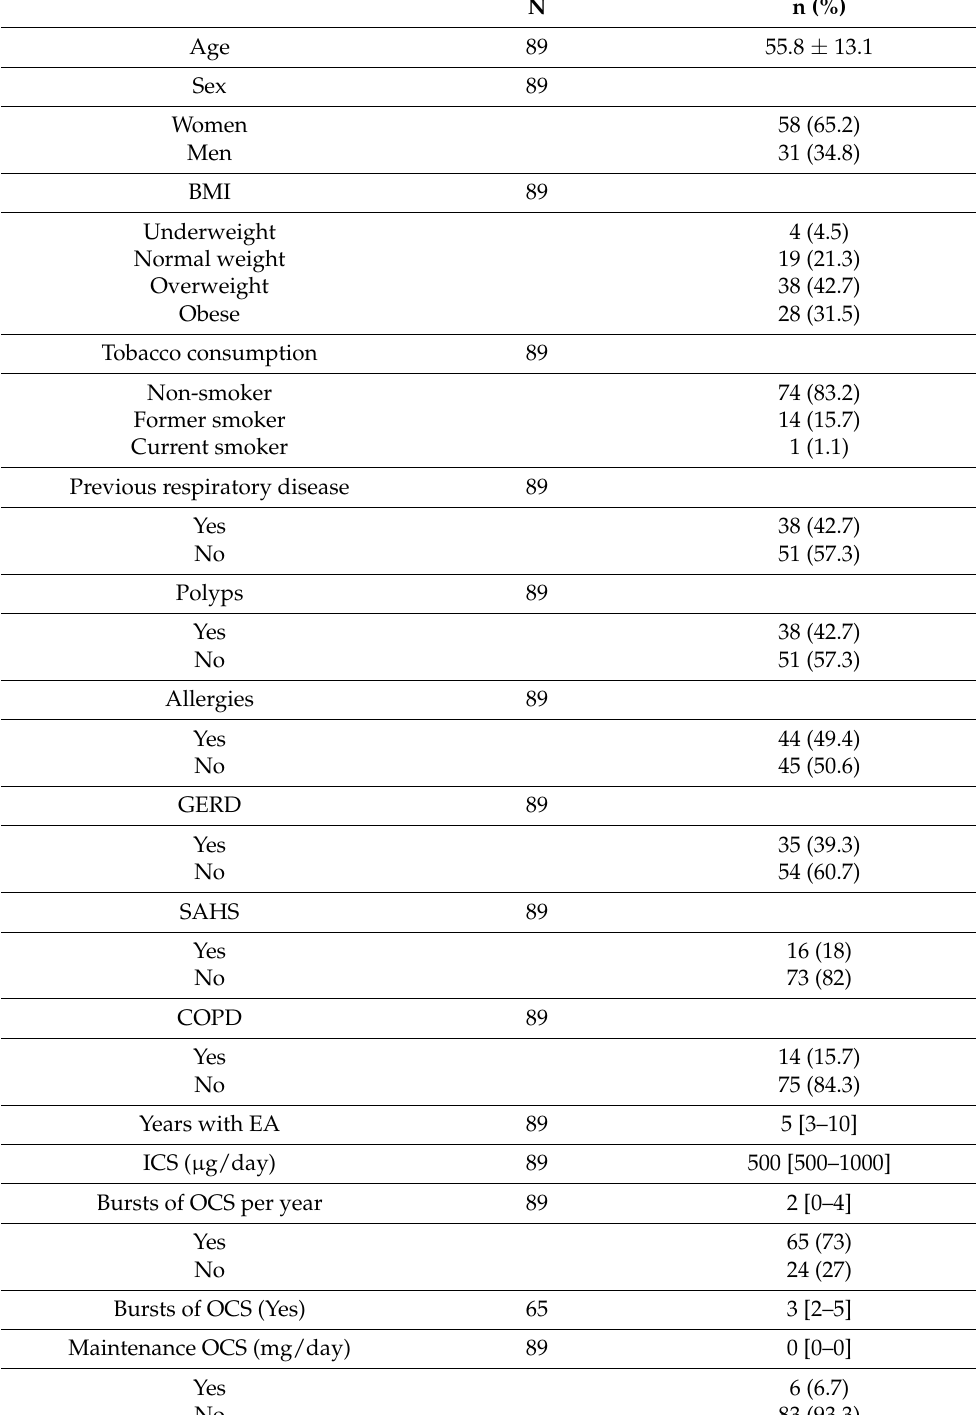
Table 1. Demographic and clinical characteristics of patients treated with